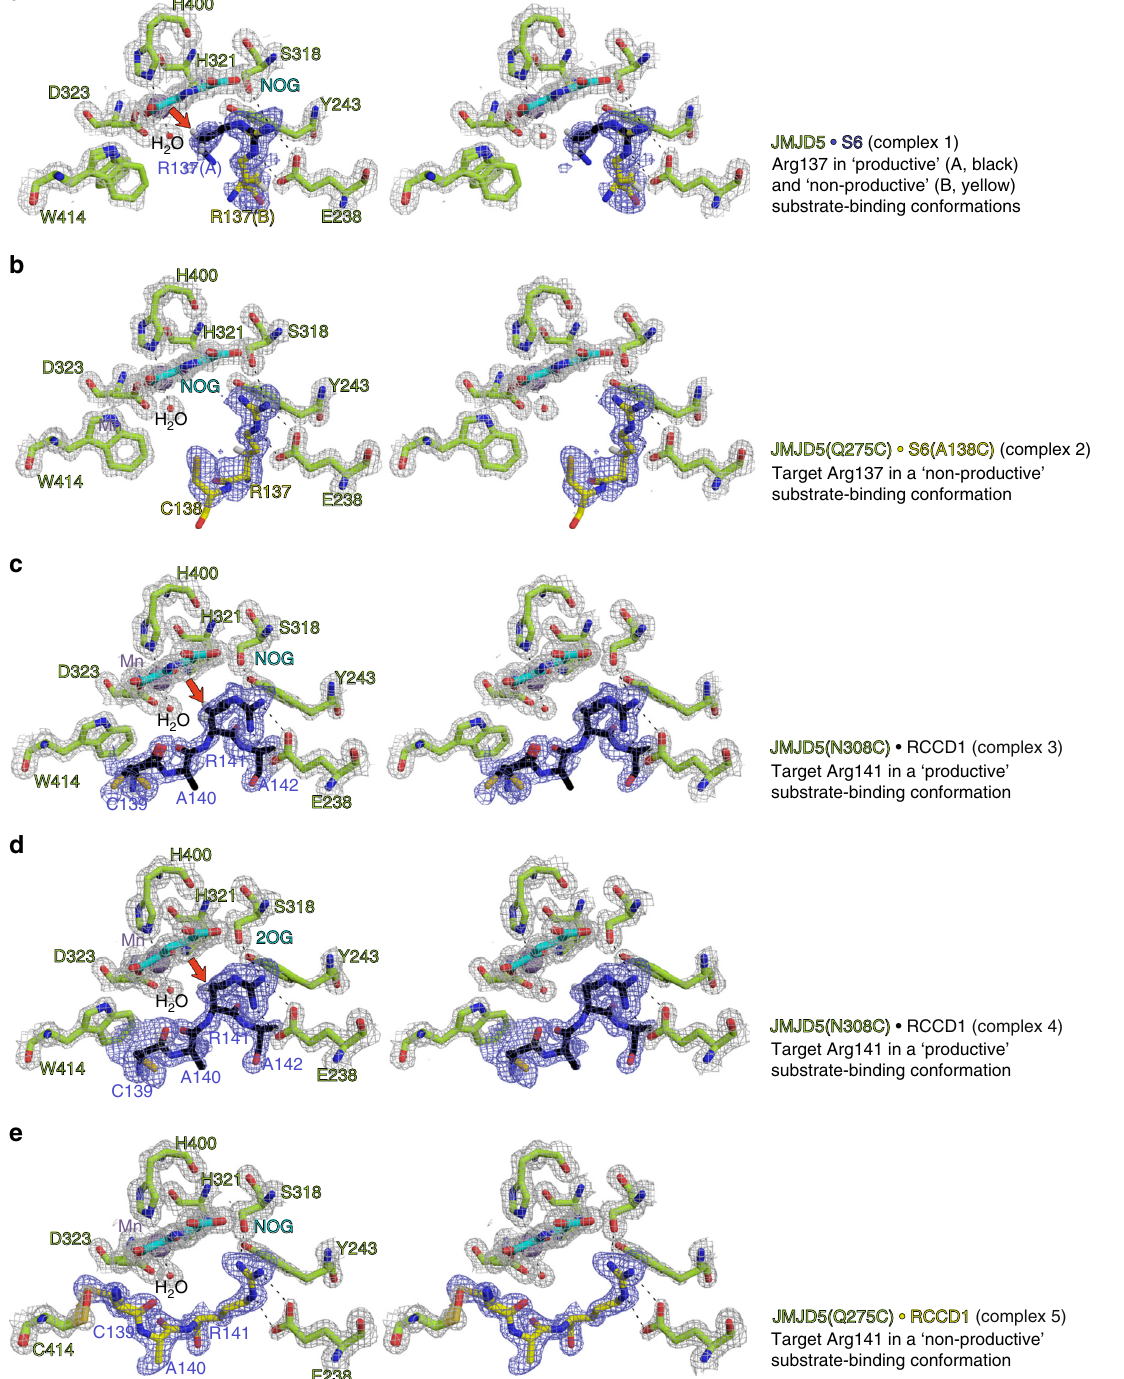
Fig. 3 Stereoviews of JMJD5.substrate complexes showing likely productive and non-productive arginine-binding modes. a JMJD5.Mn.NOG.RPS6 (Complex 1, PDB: 6F4P), b JMJD5(Q275C).Mn.NOG.RPS6(A138C) (Complex 2, PDB: 6F4Q), c JMJD5(N308C).Mn.NOG.RCCD1 (Complex 3, PDB: 6F4R), d JMJD5(N308C).Mn.2OG.RCCD1 (Complex 4, PDB: 6F4S) and e JMJD5(W414C).Mn.NOG.RCCD1 (Complex 5, PDB: 6F4T). The target arginine in both RPS6 (R137) and RCCD1 (R141) binds in a shallow channel on the JMJD5 surface forming hydrophobic interactions with Y243/W310 and hydrogen bonds with E238/ S318 in both 'productive' (Complex 1/A, Complex 3 and Complex 4) and 'non-productive' (Complex 1/B, Complex 2 and Complex 5) conformations. 2 F o − F c (grey meshes) for JMJD5 and difference electron density ( F o − F c OMIT map, blue) for substrates are contoured to 1.2 − 1.5 σ and 3 σ , respectively. Red arrows indicate hydroxylated C – H